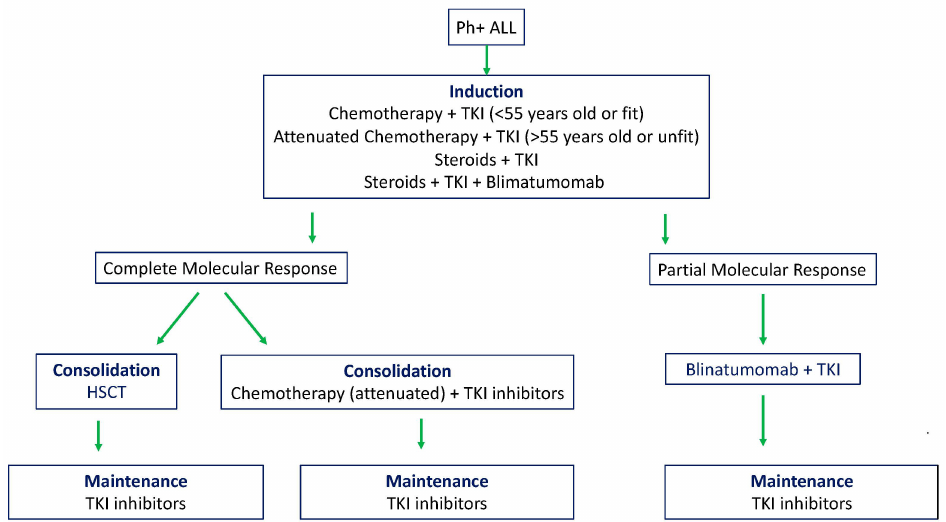
Figure 2. Treatment of adults with Philadelphia positive B-cell ALL. HSCT, hematopoietic stem cell transplant; TKI, tyrosine kinase